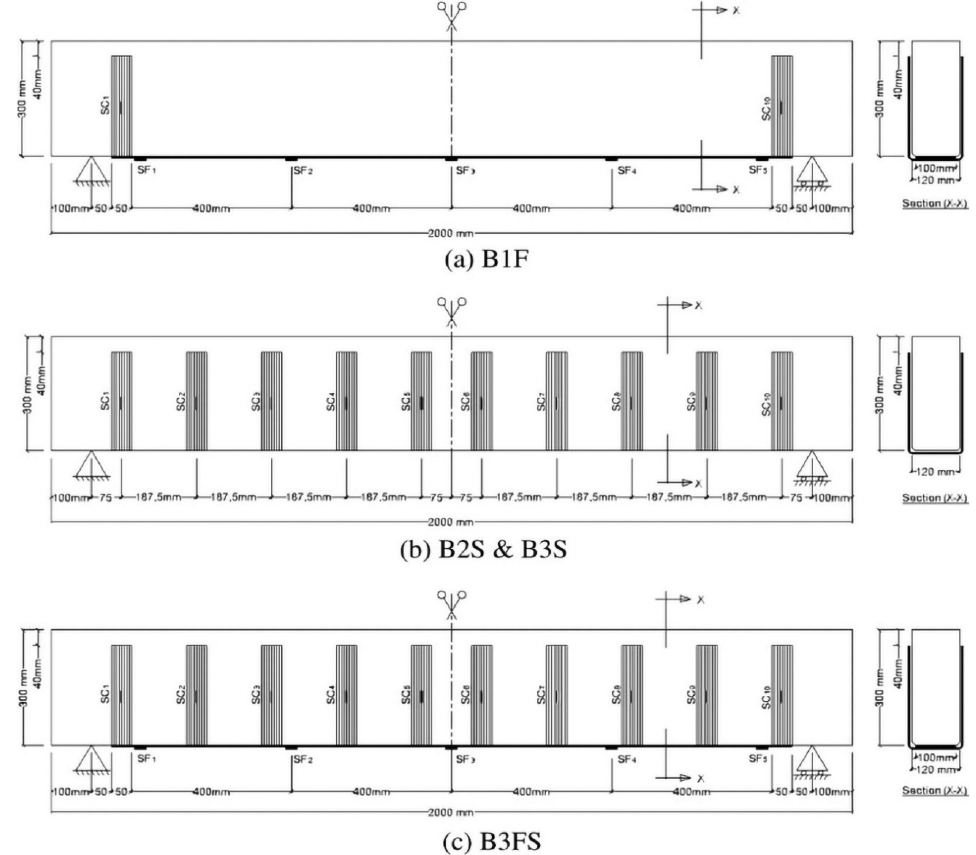
Figure 7. Wrapping scheme for shear strengthening [59].